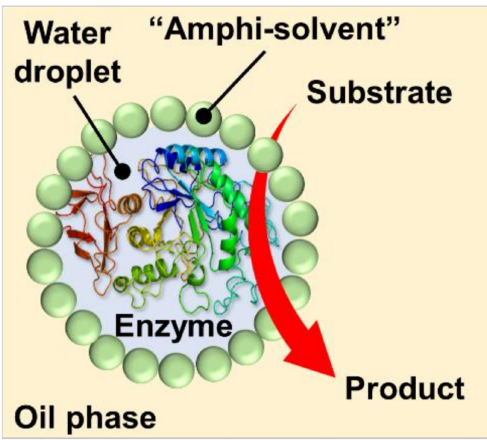
Figure 36. The principle of enzymatic transformations in a W/O surfactant-free